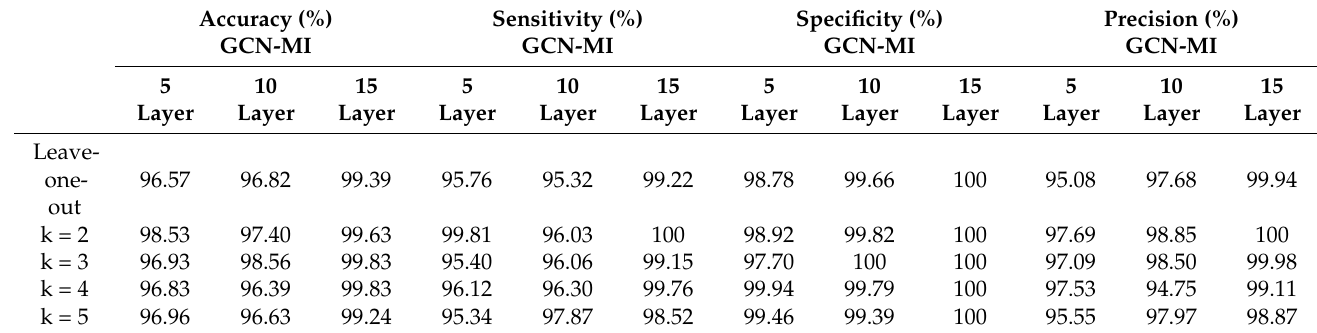
Table 2. The performance values for GCN-MI-5, GCN-MI-10, and GCN-MI-15 in the testing set with the k-fold cross-validation method.